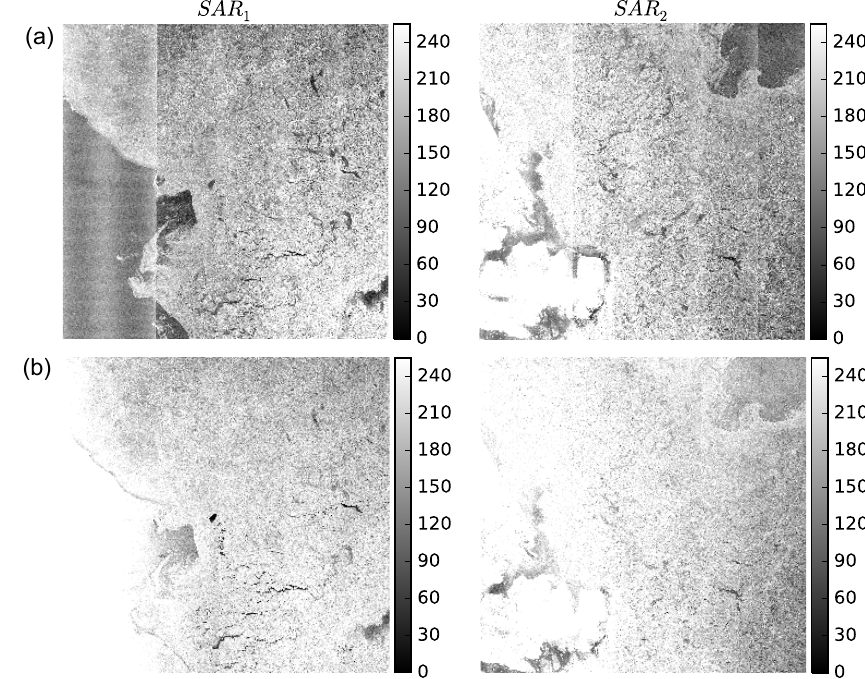
Figure 3. Image pair Fram Strait in (a) HV and (b) HH polarisation after conversion (Eq. 2) from backscatter values σ 0 into intensity values with range 0 ≤ i ≤ 255 using lower and upper brightness boundaries for HV: σ 0 =− 25.0dB, σ 0 =− σ 0 max min